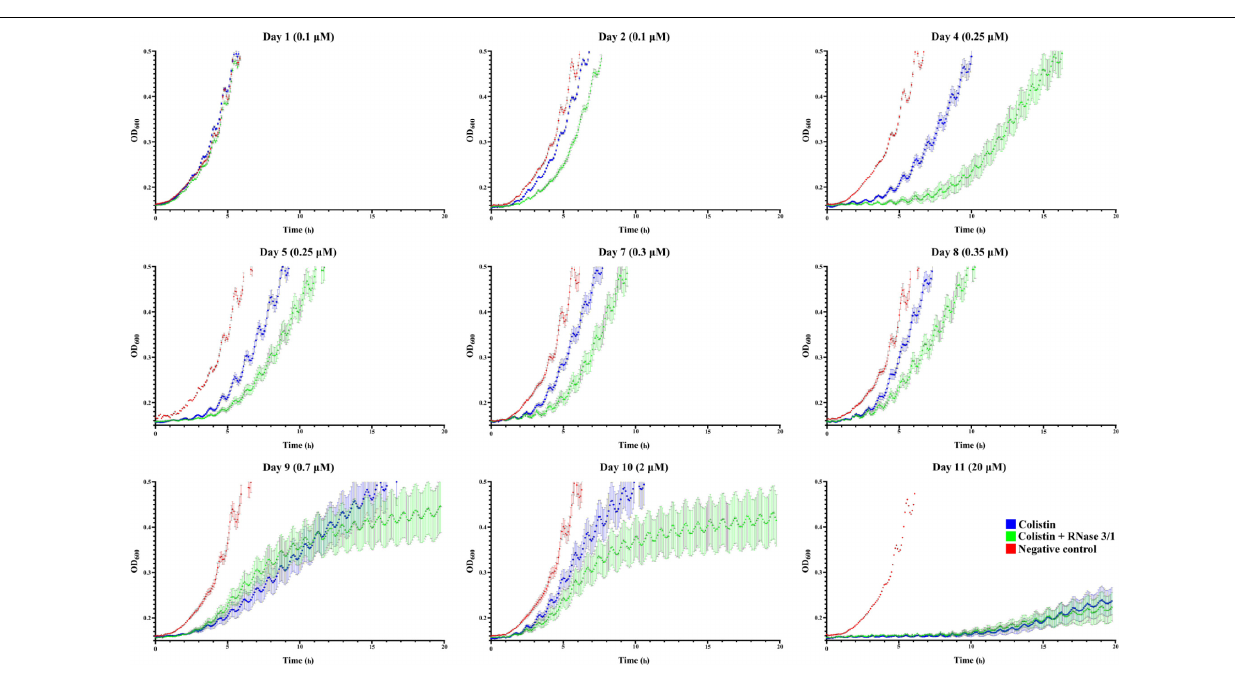
FIGURE 5 | A. baumannii growth curves at representative days of exposure. Bacterial culture growth was monitored following 1/150 dilution by OD 600 reading. Points represent the mean of all the lineages for each day and condition. In red is shown the negative control, in blue the colistin-exposed cultures and in green, the colistin + RNase 3/1 conditions. Error bars represent the standard error of the mean. A statistical analysis was applied to further evaluate the significance of the observed differences between the behavior of the cultures exposed only to colistin and the cultures exposed to both colistin and RNase 3/1. Taking as a reference the time needed for the bacteria to reach the exponential phase (OD 600 = 0.4), we performed a comparison between cultures belonging to the same cycle ( Figure 6B ) and cultures of consecutive cycles within each condition ( Supplementary Figures S4 , S5